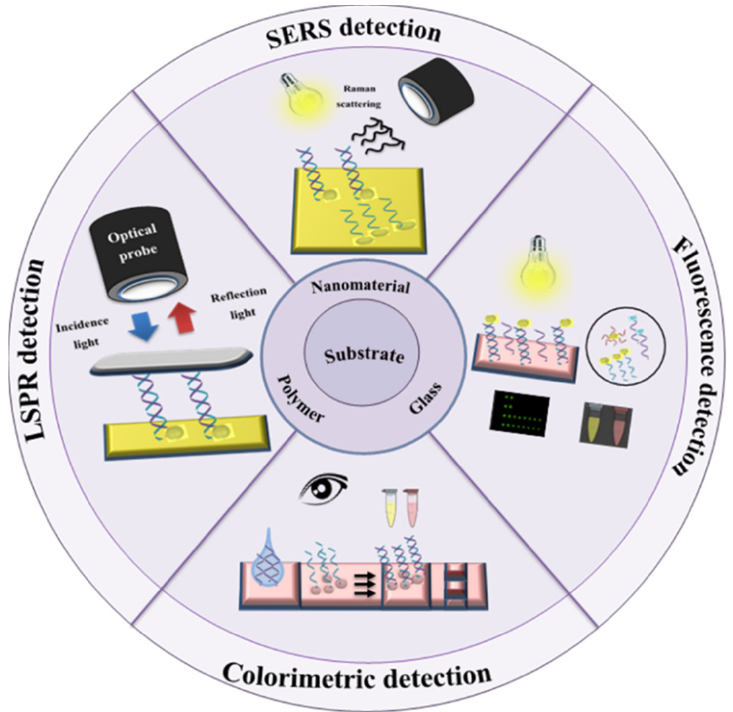
Figure 6. Schematic illustration of optical-based DNA biosensor sensing approaches: LSPR, SERS, colorimetric and fluorescence detection.